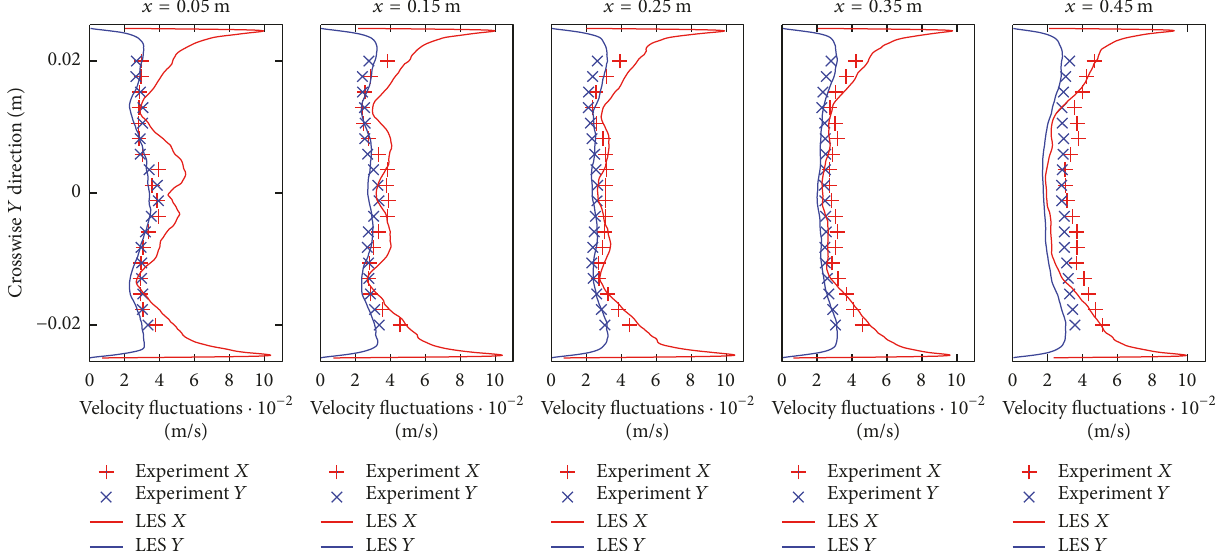
Figure 10: Velocity fluctuations profiles at different locations for the single liquid